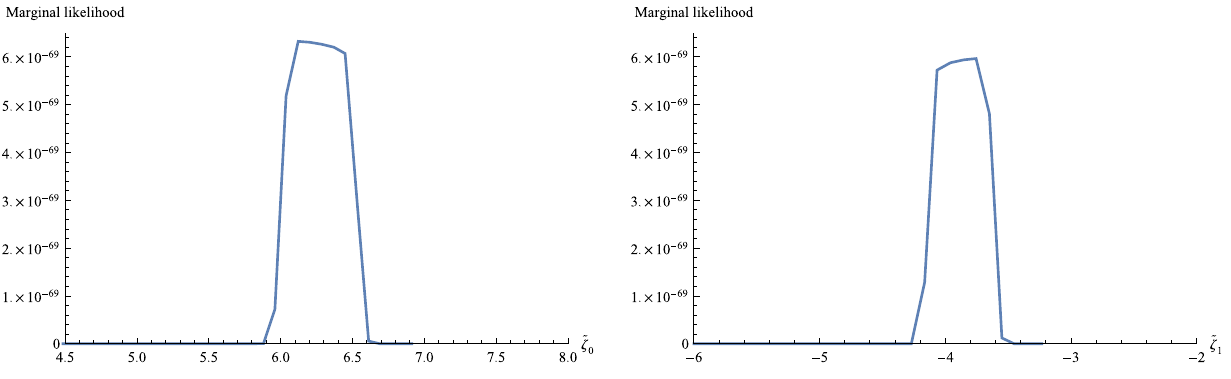
Fig. 2 Marginal likelihood of the parameters ˜ ζ 0 and ˜ ζ 1 corresponding to the case 2, when ζ = ζ 0 + ζ 1 ˙ a